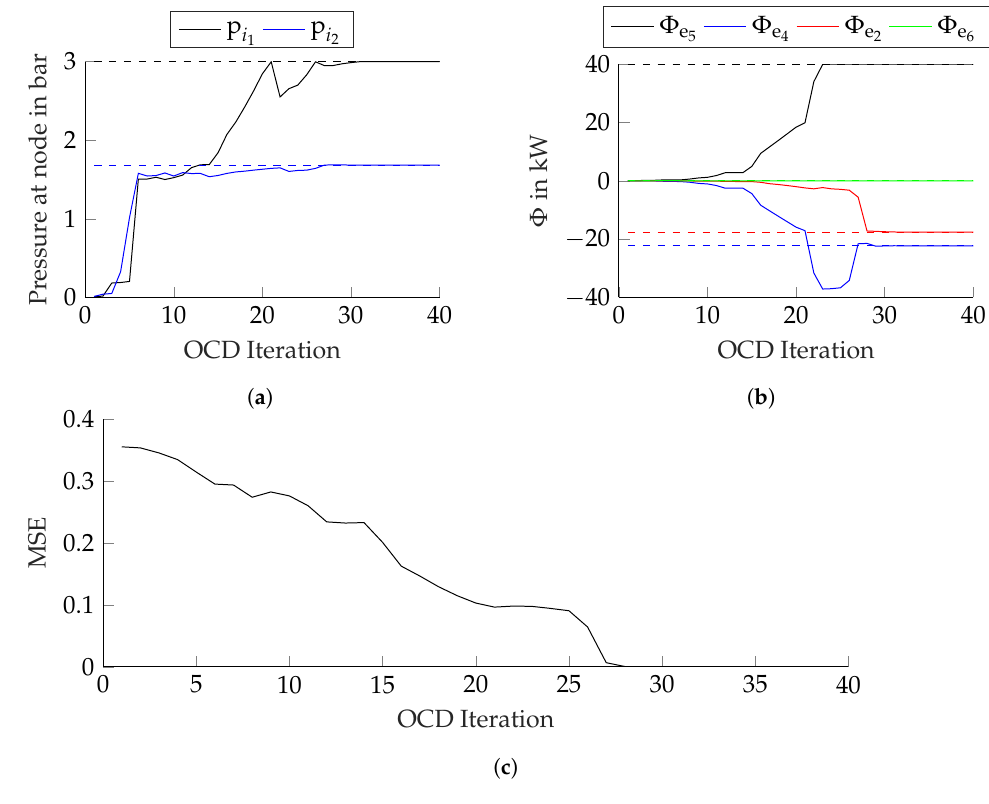
Figure 4. Four-node network from Figure 1 solved from an initial point with all variables set to zero. ( a ) Pressures at nodes one and two; ( b ) Thermal power output/consumption of consumers and producers; ( c ) Mean Square Error as defined in (32).